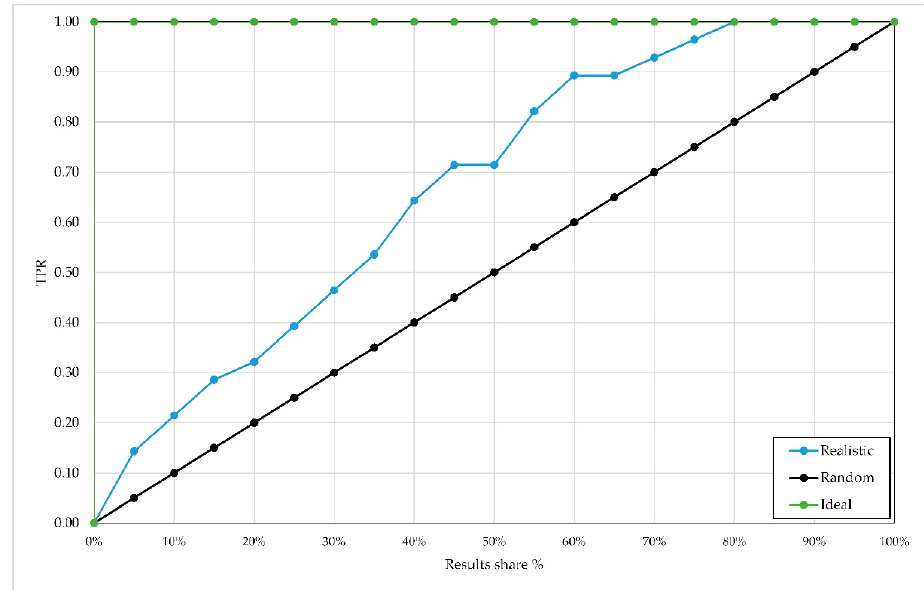
Figure 3. Three representative lift charts plotted in 5% increments: (1) realistic stepwise (blue line), (2) random guess—referent (black), (3) ideal (green). True positive rate is placed on the y -axis and share of total results on the x -axis.